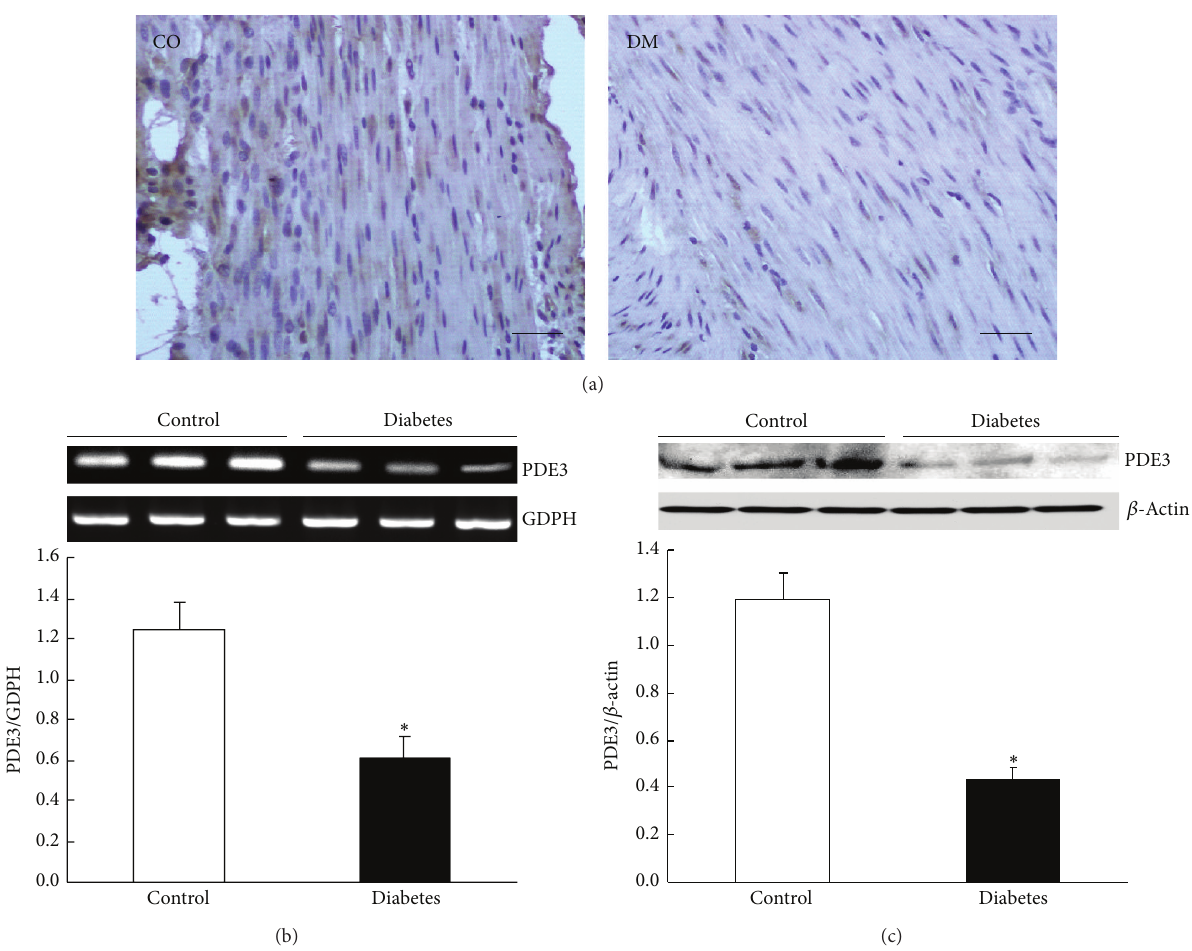
Figure 4: Expression of PDE3 in the gastric smooth muscle. (a) PDE3 immunoreactivity in gastric smooth muscle was lower in the diabetic rats than in controls (bars = 20 𝜇 m). (b) The mRNA level of PDE3 in the gastric smooth muscle was downregulated in the diabetic rats ( 𝑛 = 9 , 𝑃 < 0.05 ). (c) The protein level of PDE3 detected by Western blotting analysis in the gastric smooth muscle was significantly lower in the diabetic rats than in controls ( 𝑛 = 9 , 𝑃 < 0.05